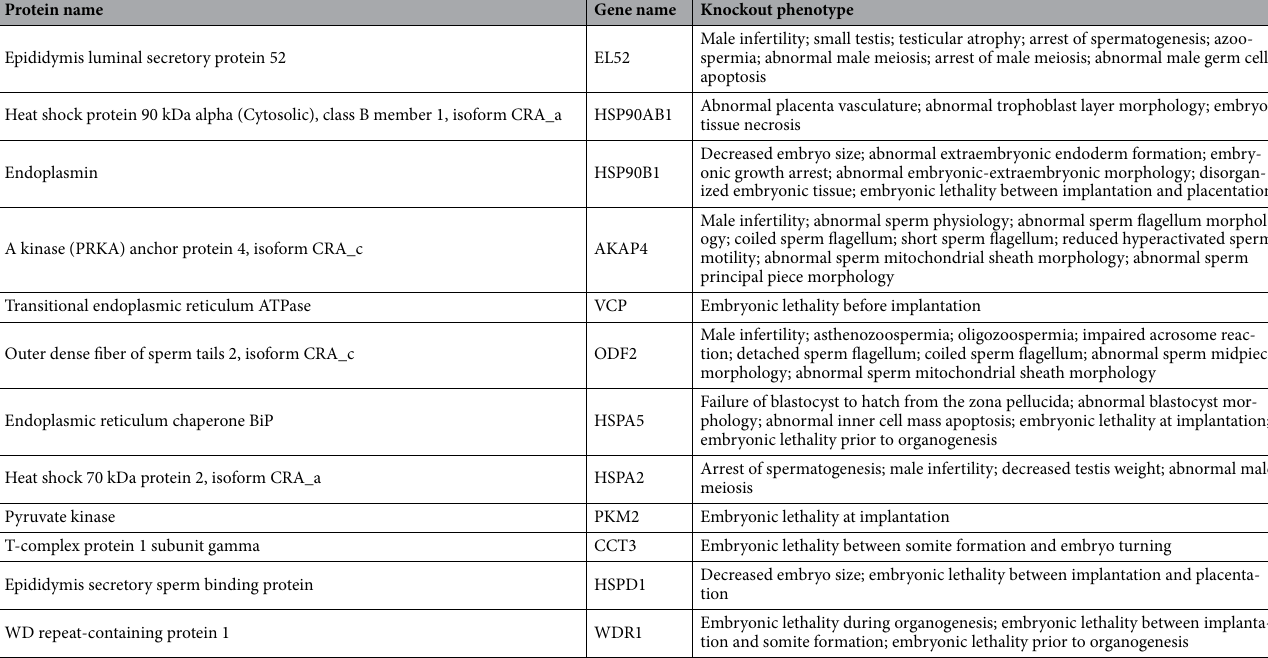
Table 2. Fertility-related knockout phenotypes in mammals. The search was performed using the MGI Batch Query search tool in the Mouse Genome Informatics database (http:// www. infor matics. jax.